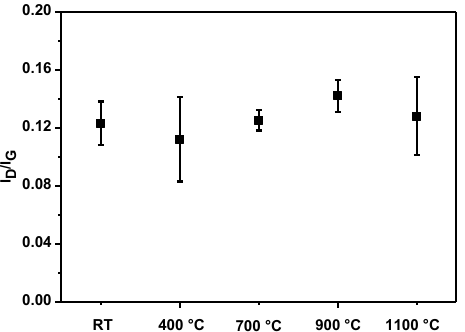
Figure 2. I D /I G values extracted from Raman spectra of purified (RT) and annealed SWCNTs (at 400, 700, 900, and 1100 °C). Each value is the average of three measurements. SWCNTs were excited 400, 700, 900, and 1100 ◦ C). Each value is the average of three measurements. SWCNTs were excited using a laser wavelength of 532 nm. using a laser wavelength of 532